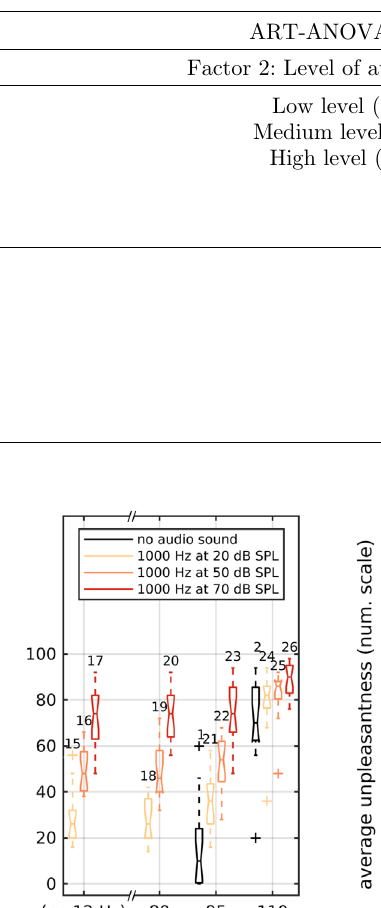
Table 3. The factors values, investigated effects and p -values of ART-ANOVA 2 are listed. Signi fi cant effects and signi fi cant interactions ( p < 0.05) are indicated by an asterisk. The factor level “ low level (1) ” of the factor ‘ level of audio sound ’ corresponds to the unpleasantness rating of the sinusoid at 1000 Hz at 20 dB SPL or of the broadband at 21 dB SPL. In addition, the factor value “ medium level (2) ” corresponds to the unpleasantness rating of the sinusoid at 1000 Hz at 50 dB SPL or of the broadband at 36 dB SPL, and the factor level “ high level (3) ” corresponds to the unpleasantness rating of the sinusoid at 1000 Hz at 70 dB SPL or of the broadband at 53 dB SPL.